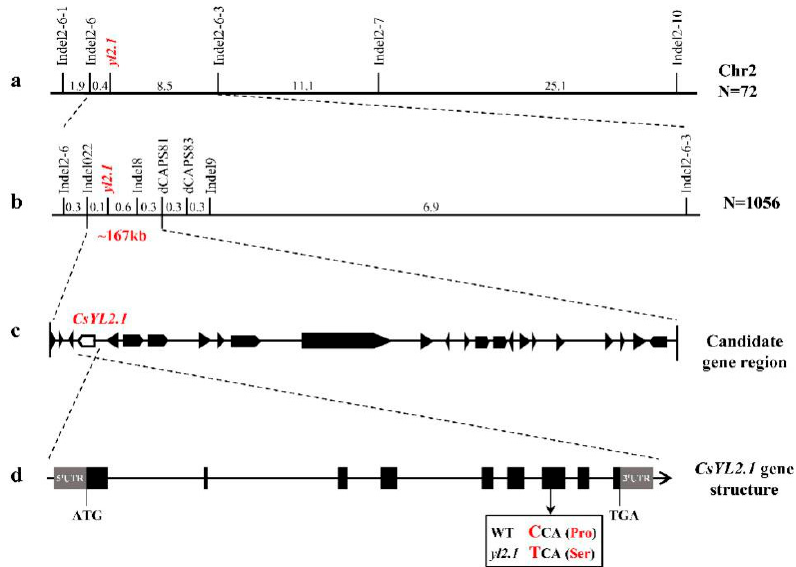
Figure 2. Map-based cloning of the YL2.1 locus in cucumber. ( a ) Primary mapping with 72 F 2 plants placed the YL2.1 locus between InDel2–6 and InDel2–6–3 on cucumber chromosome 2. ( b ) Fine mapping with 1056 F 2 plants narrowed down the YL2.1 locus to a 167-kb region delimited by two markers Indel22 and SNP81. Numbers are genetic distances (cM) between adjacent markers. ( c ) Twenty-four genes were predicted in the 167 kb region; CsYL2.1 (fourth) is the candidate gene. ( d ) Structure of the CsYL2.1 candidate gene, which has nine exons. The SNP in the seventh exon makes the proline codon (CCA) mutate to a serine codon (TCA). The gray boxes, black boxes, and black lines indicate the untranscribed region, exons and introns, respectively.